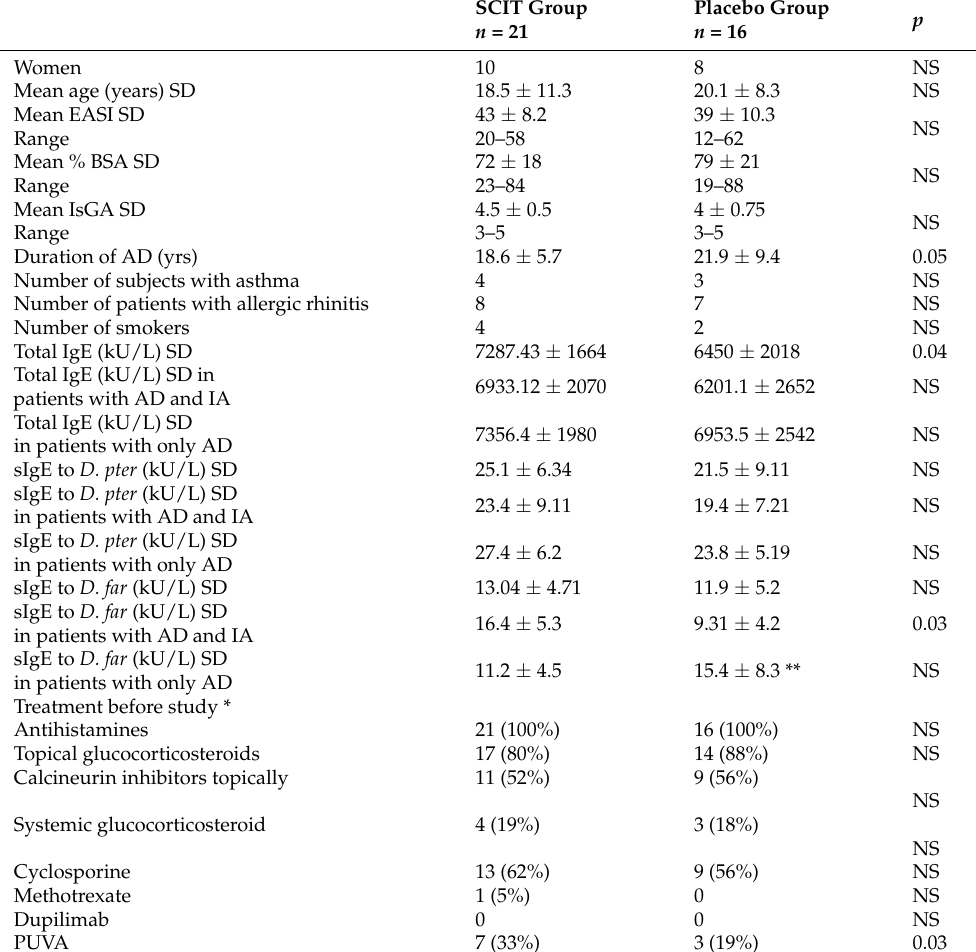
Table 1. Characteristic of study